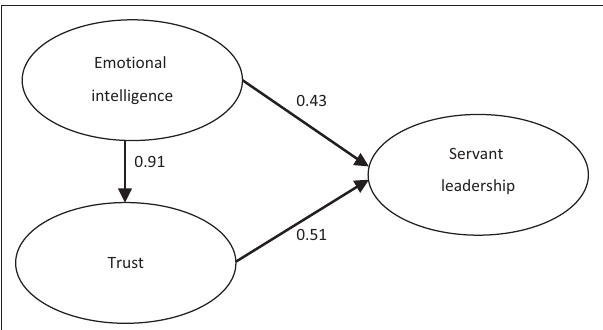
FIGURE 2: Path coefficients of the structural model with emotional intelligence, trust and servant